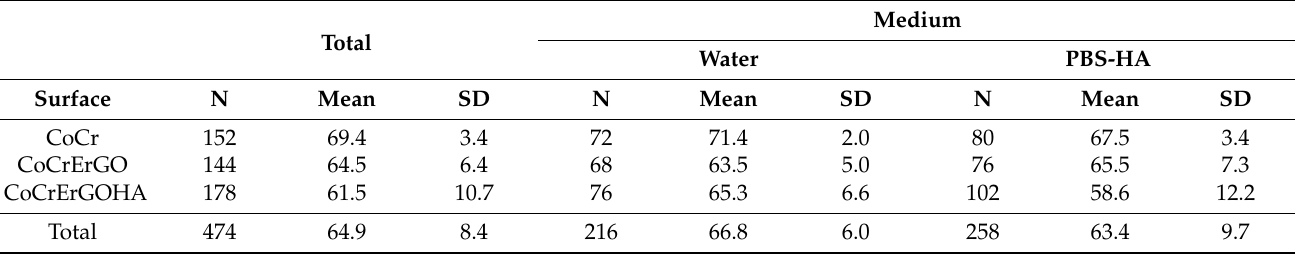
Table 1. Statistical data of the contact angle in different surface combinations: CoCr, CoCrErGO, and CoCrErGOHA and medium: Water and